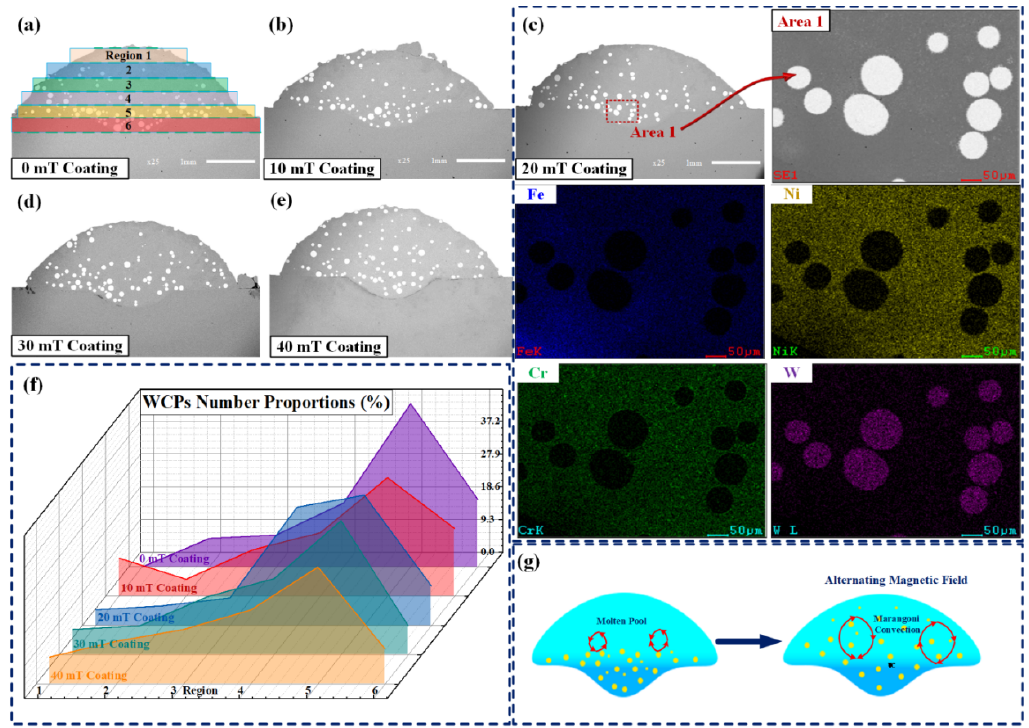
Figure 3. ( a ) The cross-sectional morphologies of coating of 0 mT; ( b ) the cross-sectional morphologies of coating of 10 mT; ( c ) the cross-sectional morphologies and the element map of Cr, Fe, Ni, W of coating of 20 mT; ( d ) the cross-sectional morphologies of coating of 30 mT; ( e ) the cross-sectional morphologies of coating of 40 mT; ( f ) the WCP proportions in particle volume ranges of coatings; ( g ) schematic diagram of the evolution mechanism of the WCP distribution.